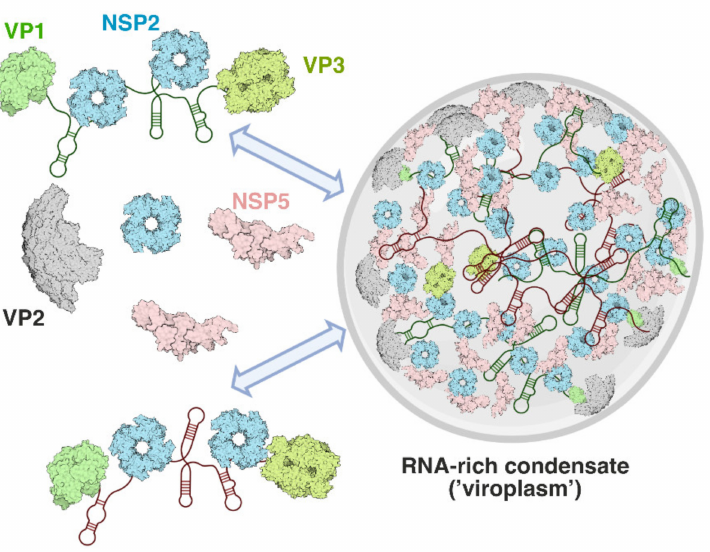
Figure 4. (diagram). Assembly of viroplasms during rotavirus infection. NSP5 (pink) acts as